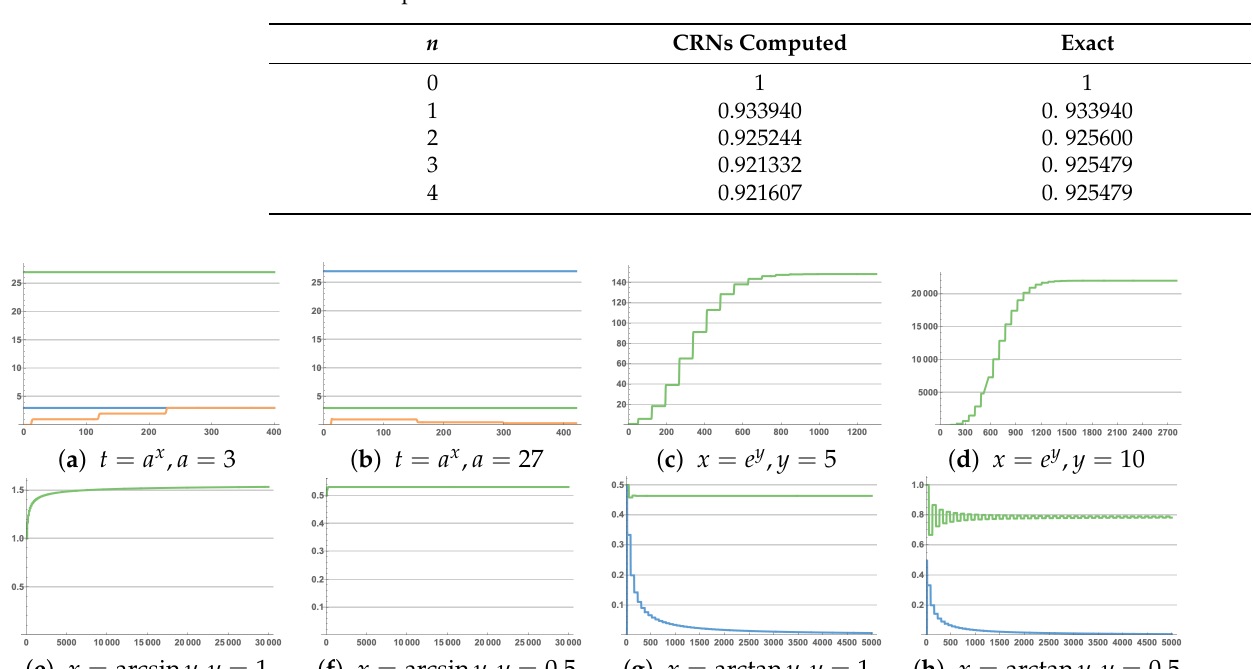
Figure 6. Solution result graph: ( a ) where a = 3 (blue), t = 27 (green), x = 3.00038 (orange); ( b ) where a = 27 (blue), t = 3 (green), x = 0.333333 (orange); ( c ) where x = 148.413 (green); ( d ) where x = 22,026.5 (green); ( e ) where x = 1.54313 (green); ( f ) where x = 0.531584 (green); ( g ) where x = 0.781827 (green) and absolute value of coefficient (blue); ( h ) where x = 0.463648 (green) and absolute value of coefficient (blue). The abscissa represents the time unit is